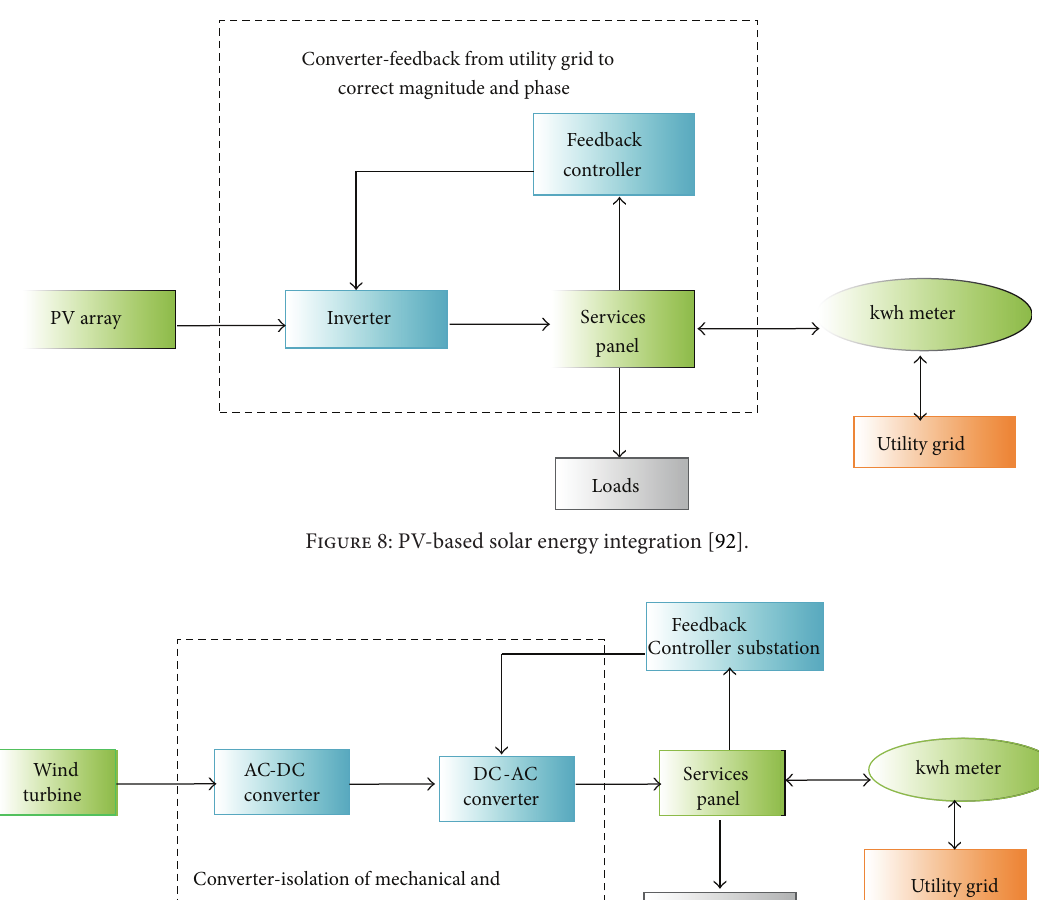
Figure 9: Wind energy integration